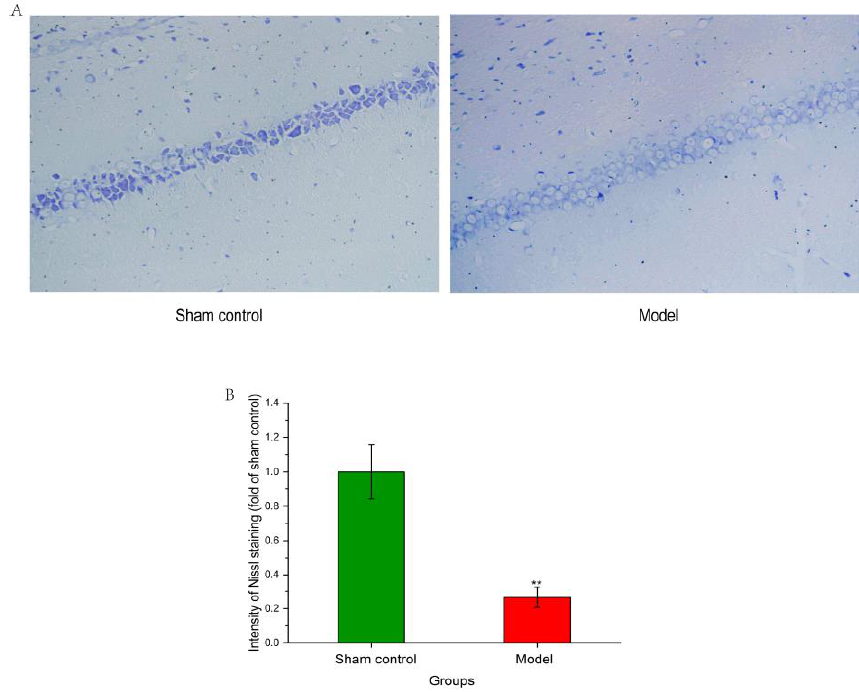
Figure 3. The effects of Aβ 1–42 on neuronal structure in the hippocampus tissues. ( A ) Nissl staining in hippocampus of the sham control and the model group. ( B ) Quantitative analysis of Nissl staining intensity. ** p < 0.01 when compared with sham control group.